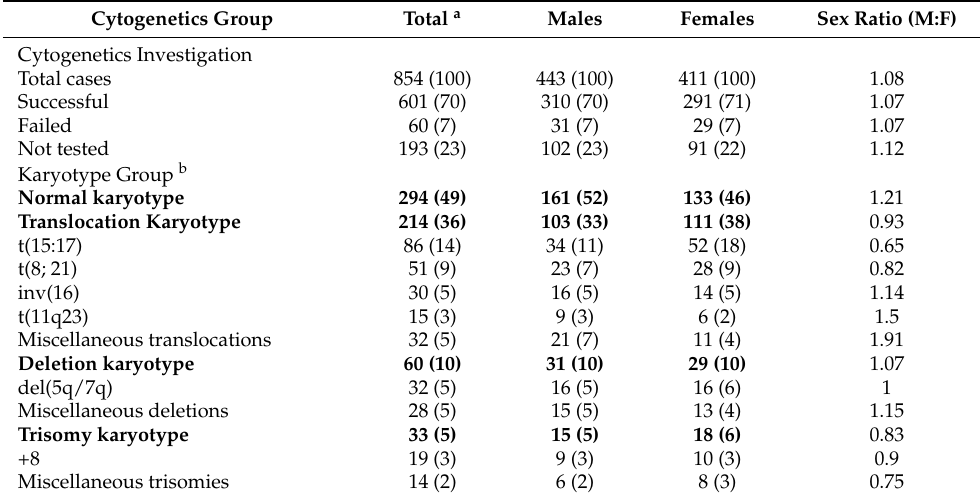
Table 2. Number (%) a of AML patients by gender and cytogenetic